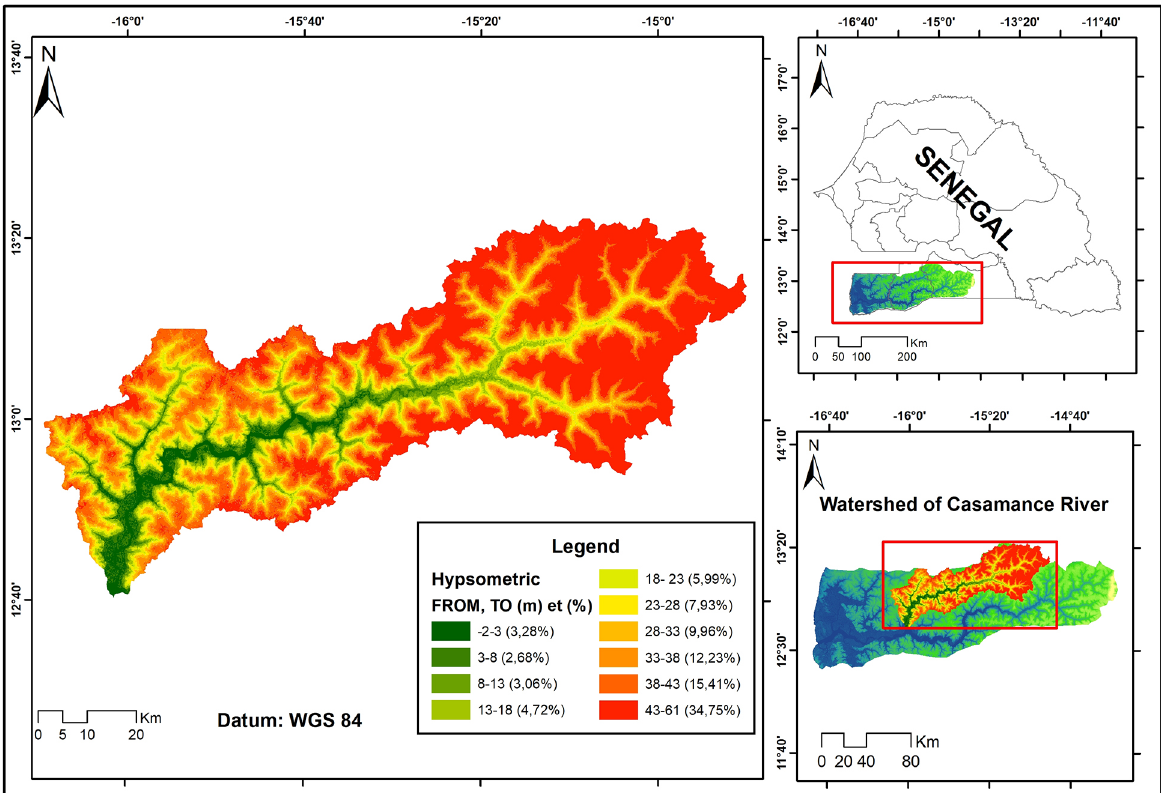
Fig. 1. Location of the Soungrougrou